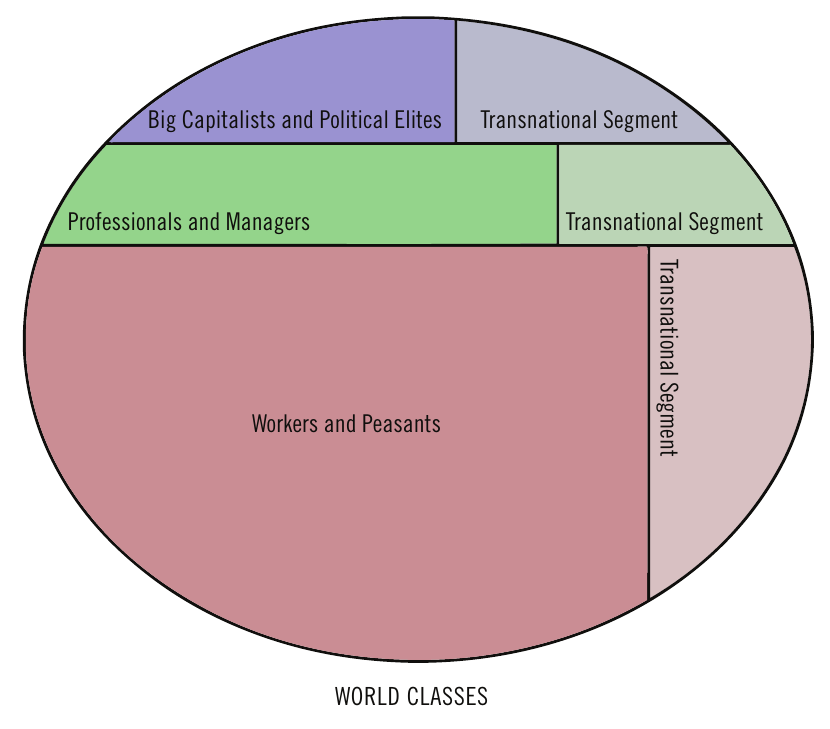
Figure 5 – World Class Structure with Transnational